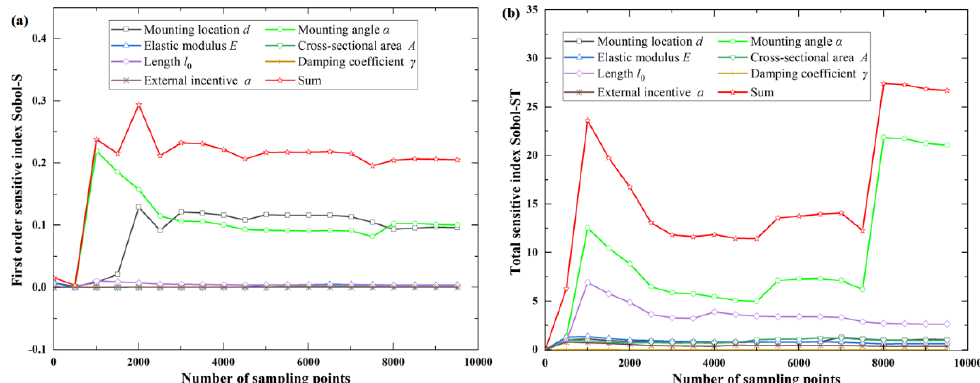
Figure 3. First-order and total sensitive index for objective function f 1 ( X ): ( a ) first-order sensitive index Sobol − S; ( b ) total sensitive index Sobol − ST.